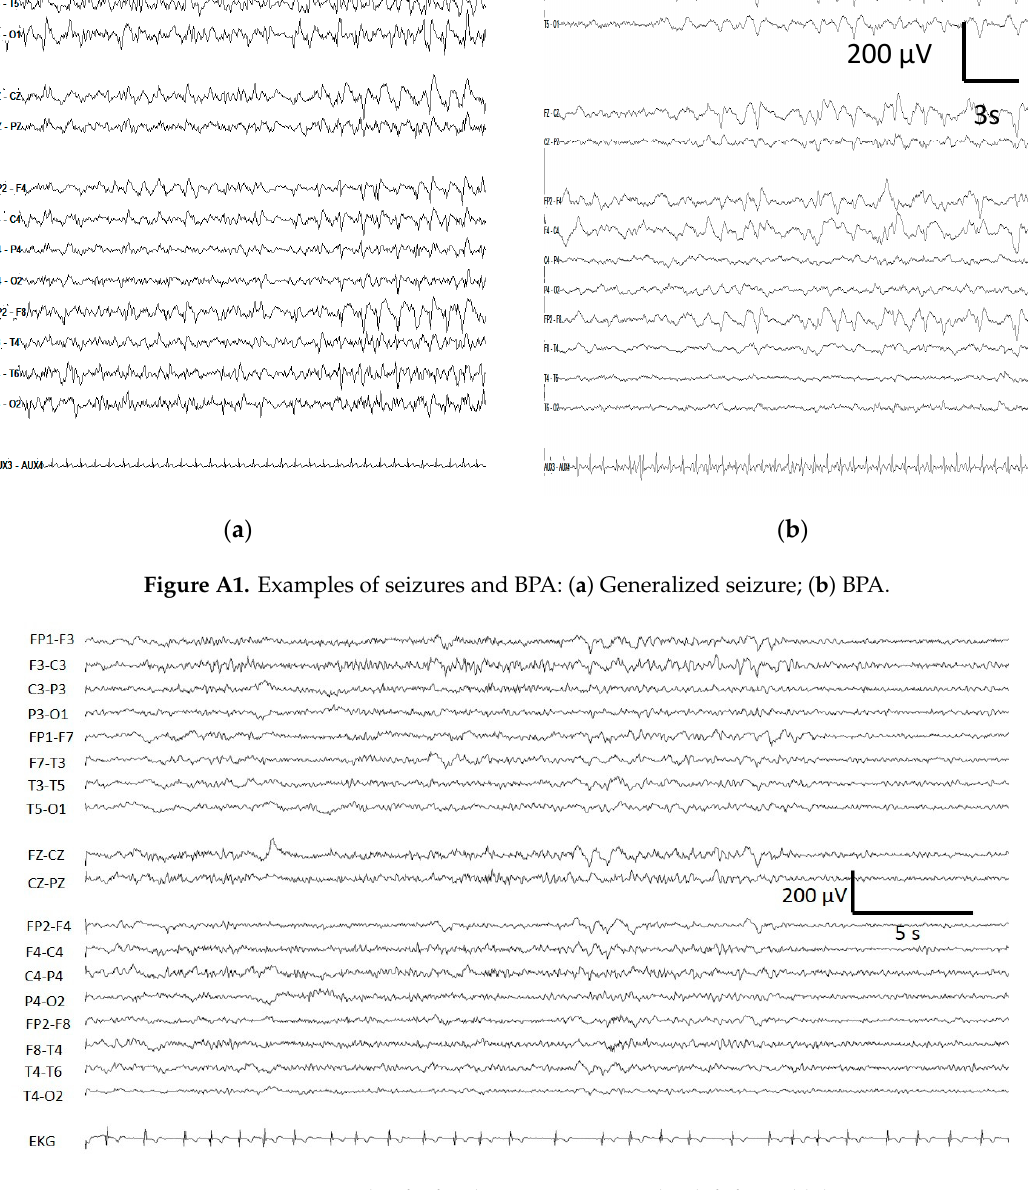
Figure A2. Example of a focal seizure originated at left frontal lobe. Statistical description and analysis of GS by